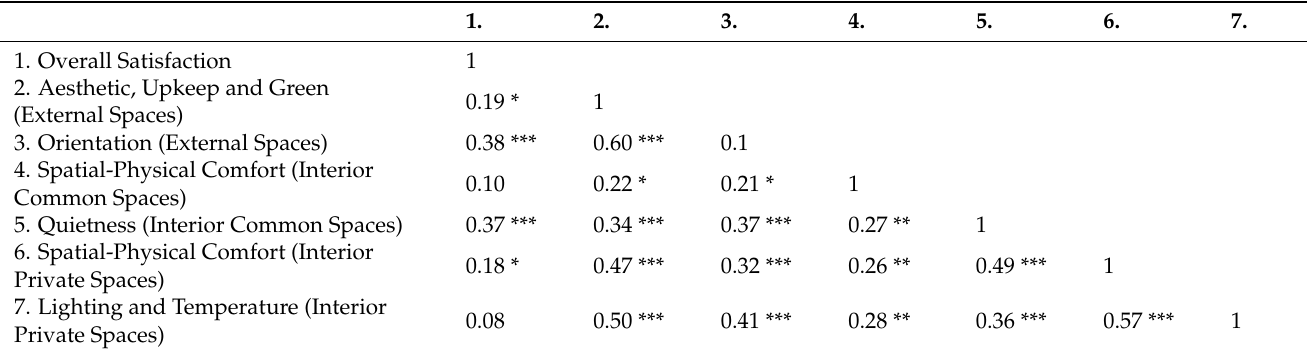
Table 2. Correlation Matrix of Overall Satisfaction and Hospice